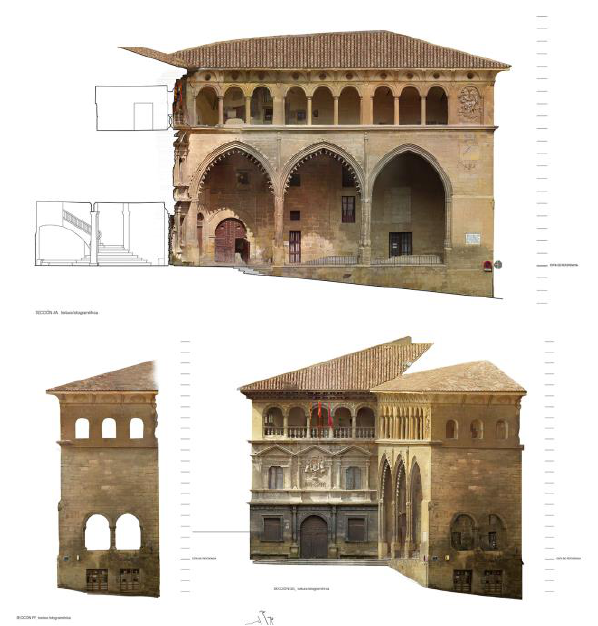
Figure 2. Photogrammetric texture of the facades and gallery of the Town Hall of Alcañiz (Teruel)